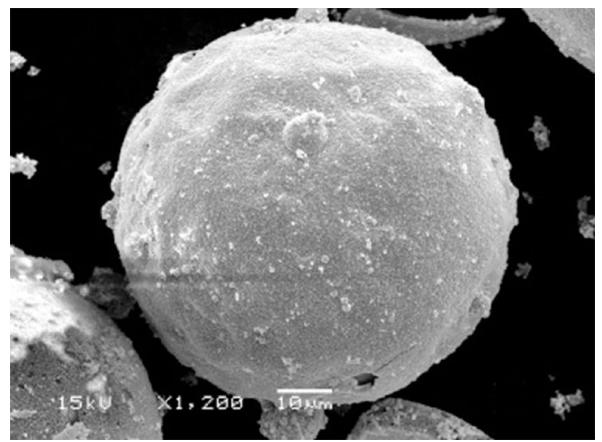
Figure 5: Ag-coated cenospheres prepared at 50 ∘ C for 20 min. The dosage of AgNO solution was 75 mL. And the concentration of 3 AgNO solution was 0.05 mol/L 3